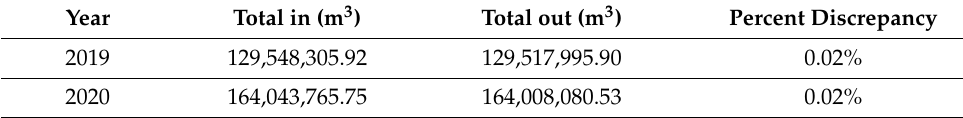
Table 10. Yearly water balance for transient groundwater modeling Scenario